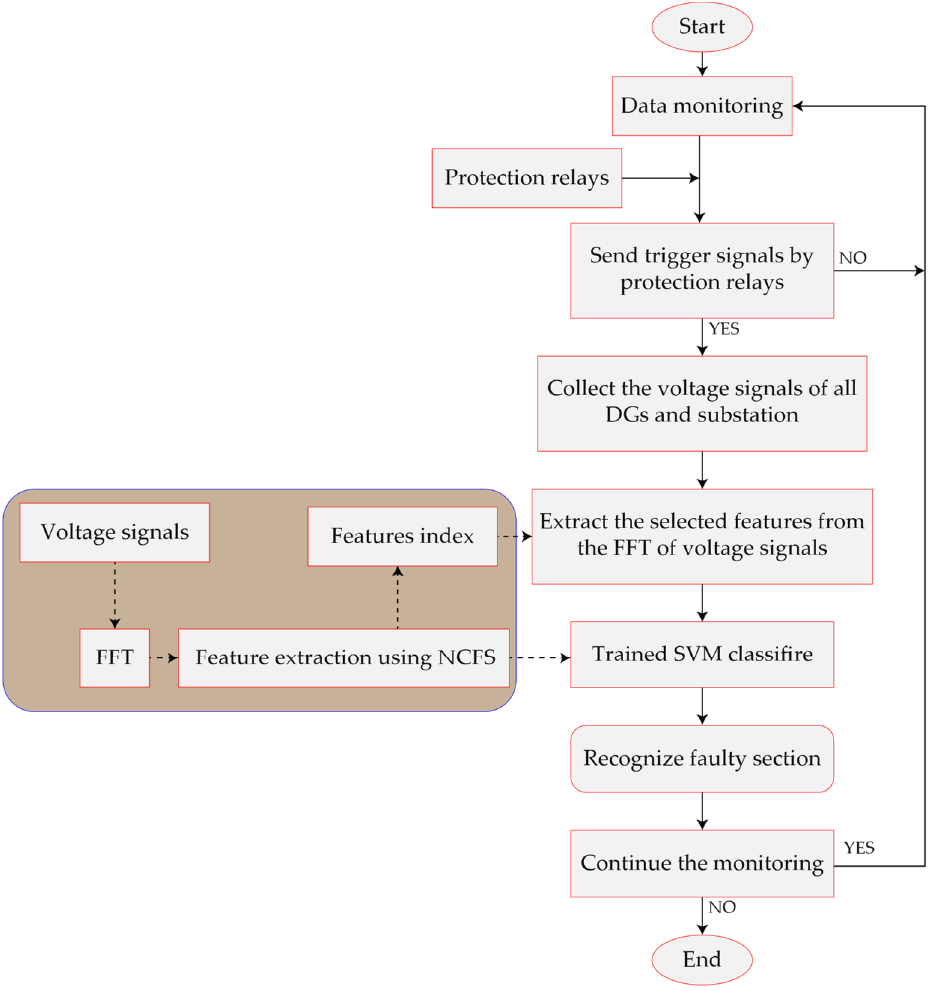
Figure 4. The flowchart of the proposed method. Algorithm 1. Machine Learning-Based Fault Location